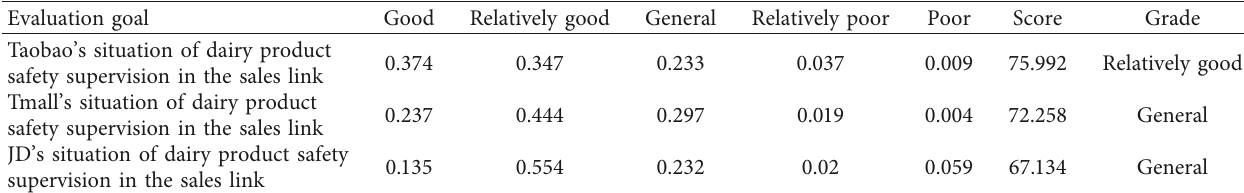
Table 9: Scores of the safety supervision of dairy products in the sales link for three e-commerce platforms 1 .